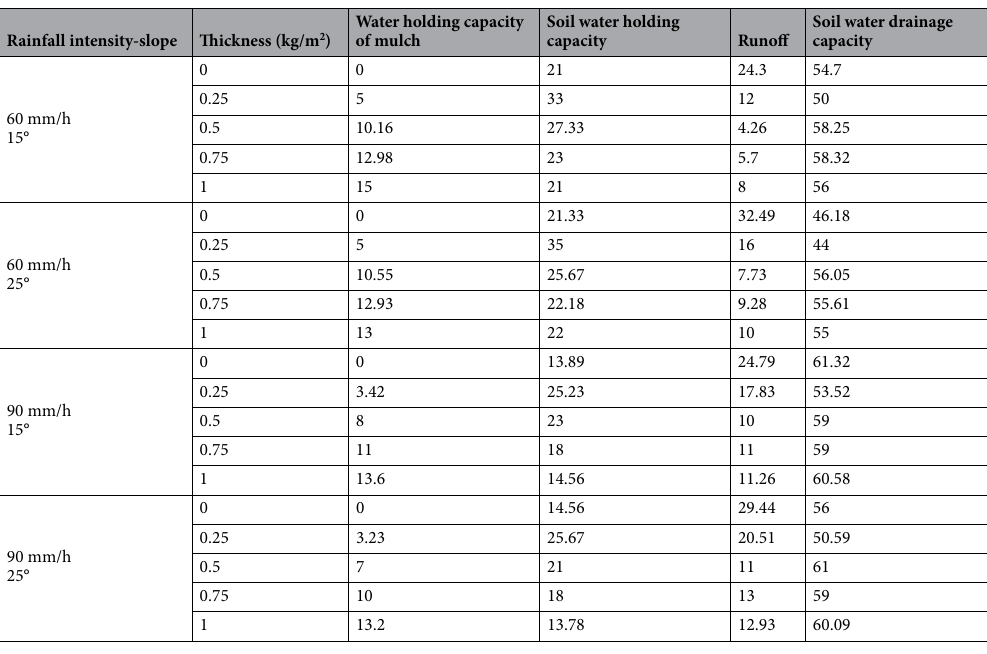
Table 6. Precipitation distribution ratio under different